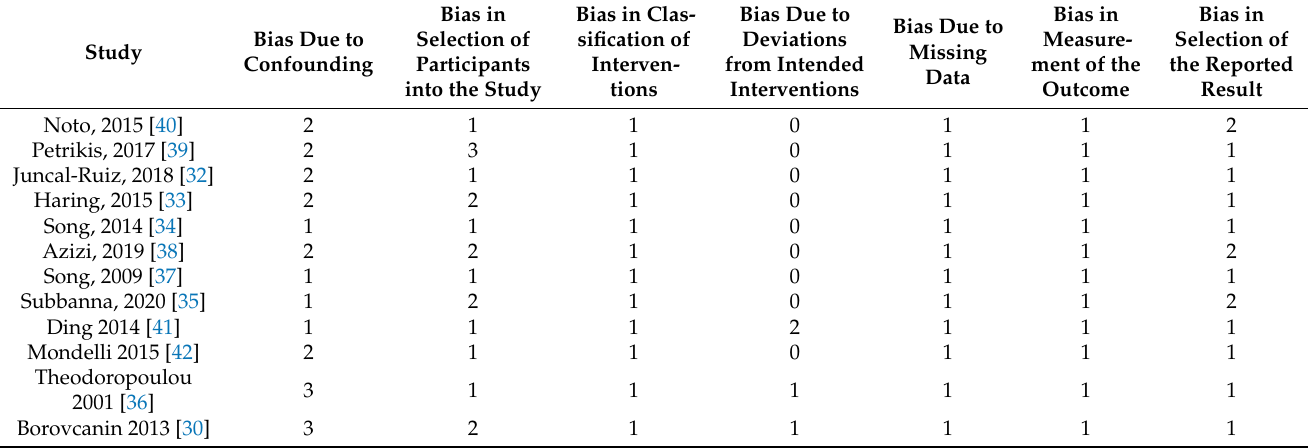
Table 3. Risk of bias: 1—Low risk of bias; 2—Moderate risk of bias; 3—Serious risk of bias; 4—Critical risk of bias; 0—No information.